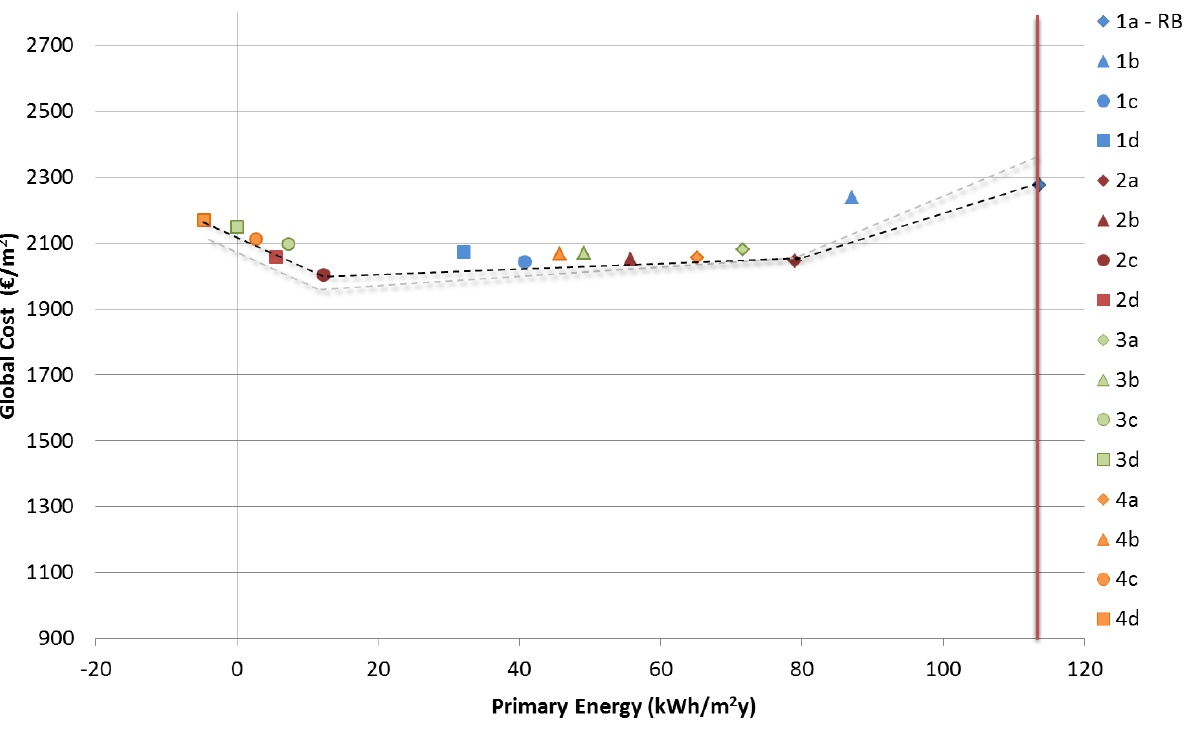
Figure 14. Sensitivity analysis with regard to the variation of the discount rate to 5%.